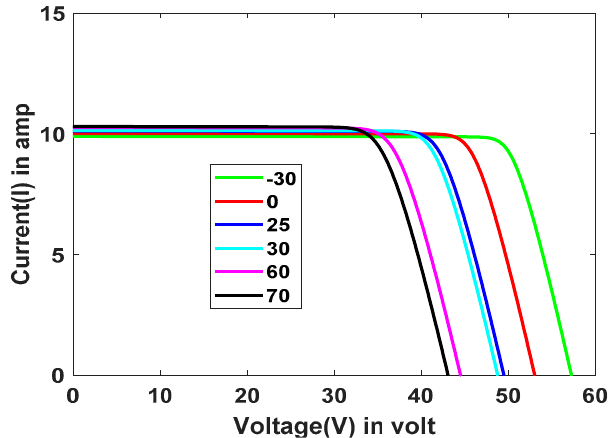
Figure 12. The IV curve obtained from simulation for Module AS ‐ M3607 ‐ S (G1 CELLS) at various temperatures while keeping irradiance fixed at 1000 W/m 2 by utilizing the Hybrid BESSA technique.